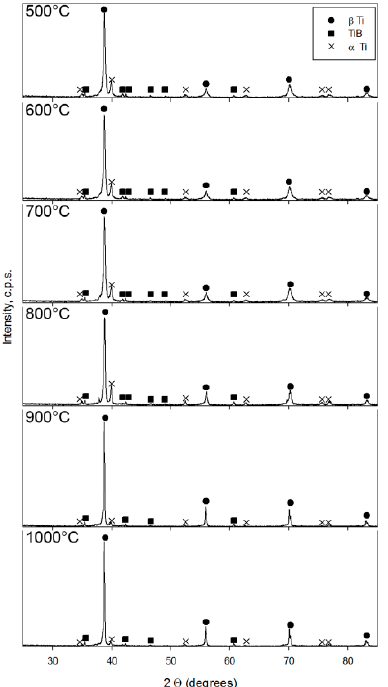
Figure 5. XRD patterns of the Ti-15Mo/TiB MMC after compression at different temperatures.